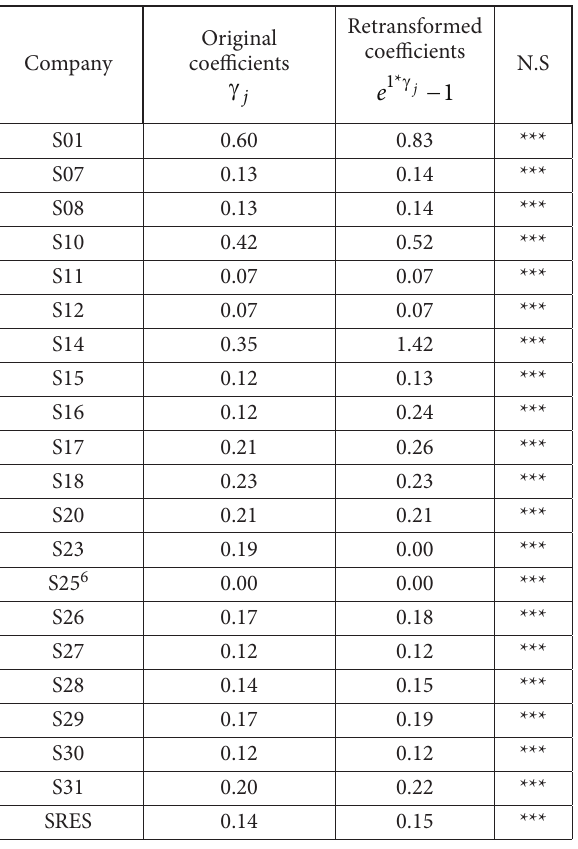
Table 6. Coefficients of the appraisers’ variables retransformed from the SEM model by ML